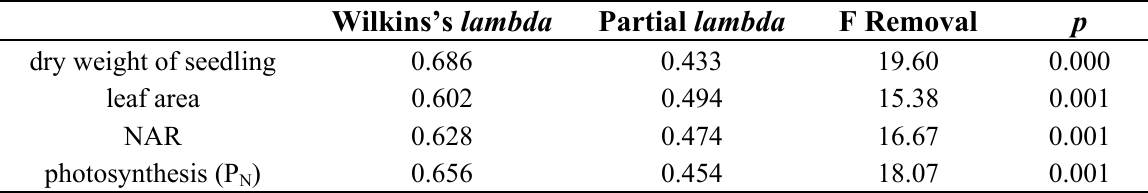
Table 6. Summary of discriminatory function analysis and squares of Mahalanobis distance from the centroids for SI index of selected